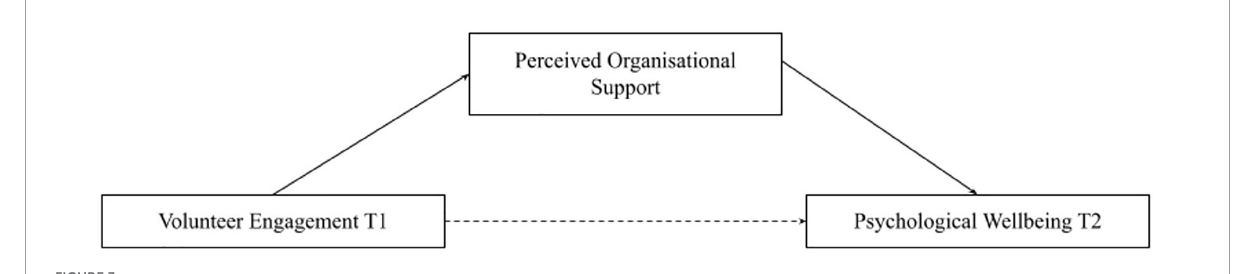
FIGURE3 Mediation model of perceived organizational support mediating volunteer engagement Tl and psychological wellbeing T2. Single headed arrows represent regression, unbroken lines represent direct effects, broken lines represent indirect